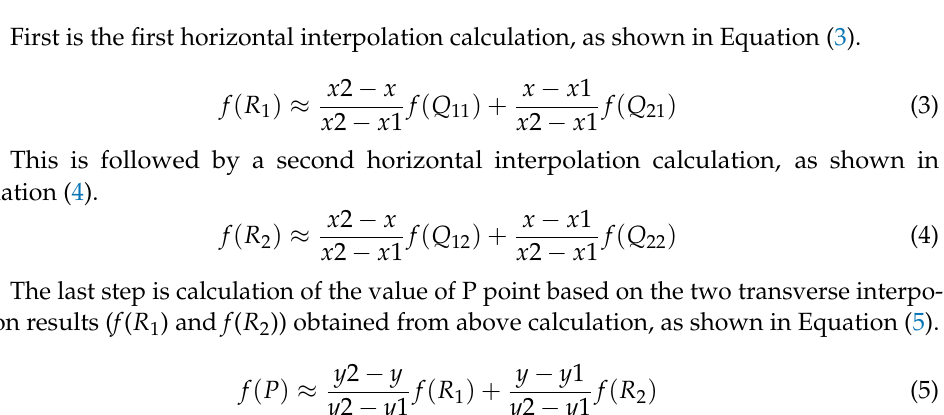
Figure 9. Schematic diagram of the bilinear interpolation method.